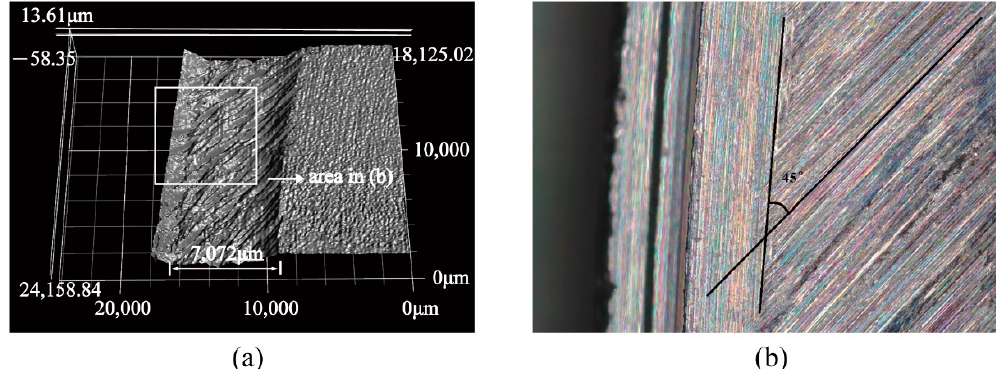
Figure 11. ( a ) Three-dimensional profile of grinding marks on the rail sample surface, ( b ) the angle between the grinding marks and the grinding direction.